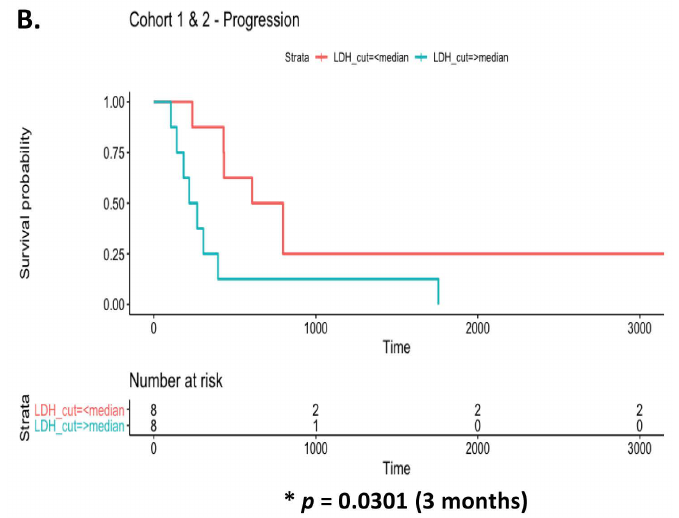
Figure 8. LDH as a prognostic biomarker of disease progression. Relative to LDH levels at baseline ( A ), high LDH levels above the median cut off ( ≥ 220.5) were significantly associated with a shorter time to disease progression at 3 months ( B ). The median cut-off for LDH at baseline was ≥ 229. Univariate Cox proportional hazards analysis of time to progression was used and Kaplan Meier survival plots represented (* p < 0.05).